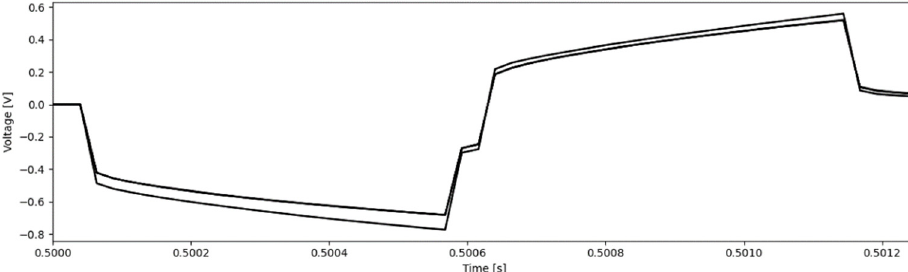
Figure 9. VT plot of one set of pulses at a charge density of 30 µ C/cm 2 after long-term electrochemical testing.